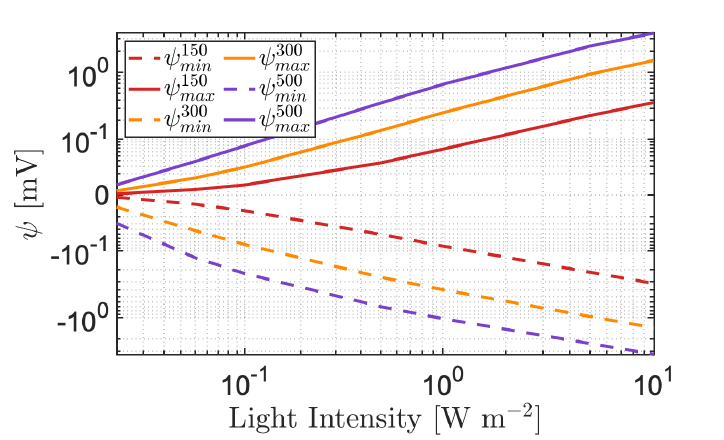
Figure 4. Electric potential minimum and maximum values (mV) as a function of the light intensity impinging onto the NP, for different values of R NP : ( a ) R NP = 150 nm (red); ( b ) R NP = 300 nm (orange); ( c ) R NP = 500 nm (purple).